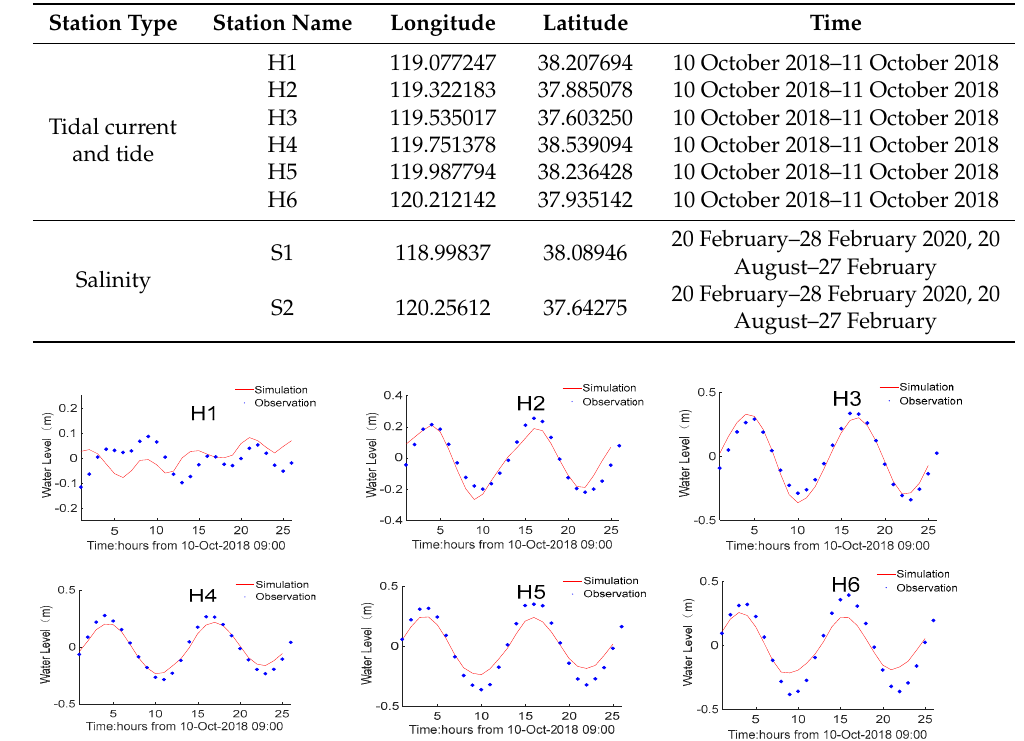
Figure 5. Station information of observations (tide and current: H1–H6; salinity: S1 and S2). Table 1. Detailed information of the observation stations.